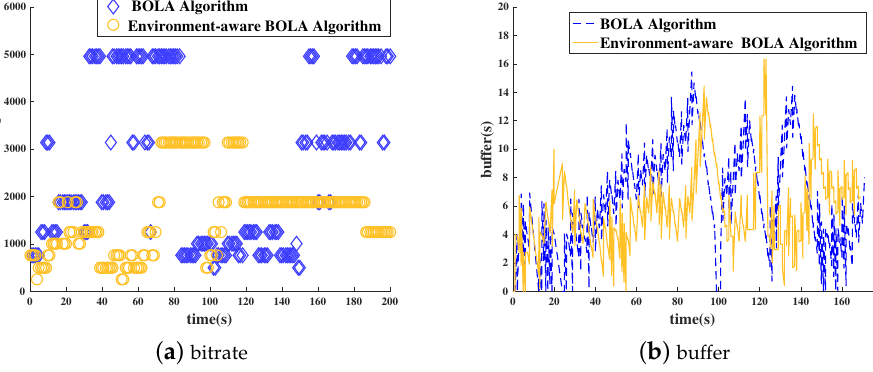
Figure 6. Bit rate and buffer (dynamic and noisy